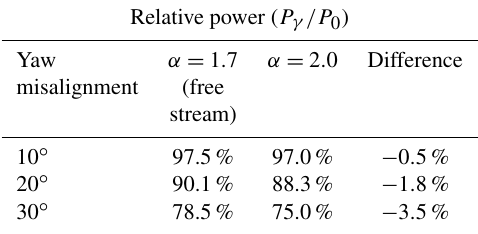
Table 1. Relative power output due to yaw misalignment for a downstream turbine located 6 D downstream for α = 2 . 0 and α = α 0